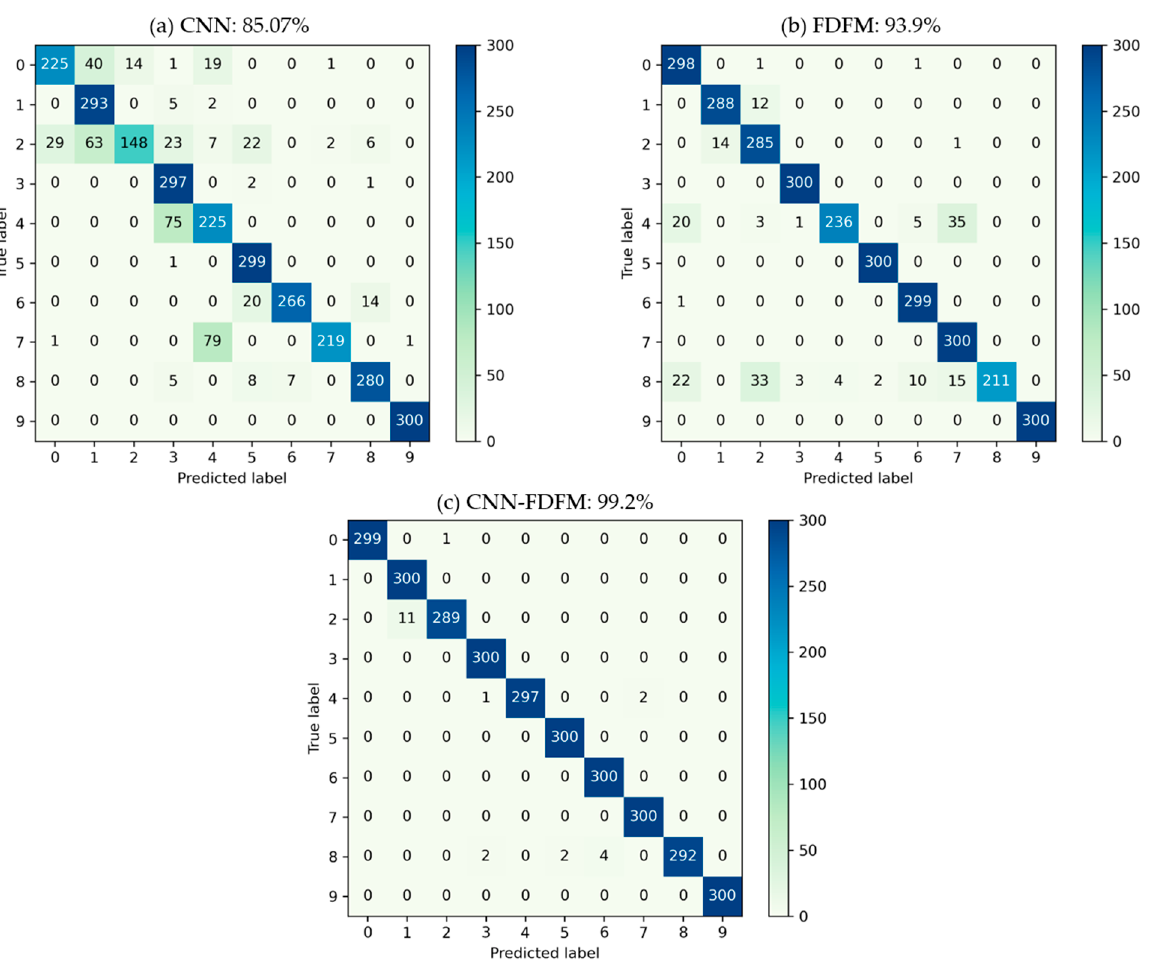
Figure 16. The classification confusion matrix of three models during fusion when the SNR of test samples is − 6 dB: ( a ) CNN; ( b ) FDFM; ( c ) CNN-FDFM.